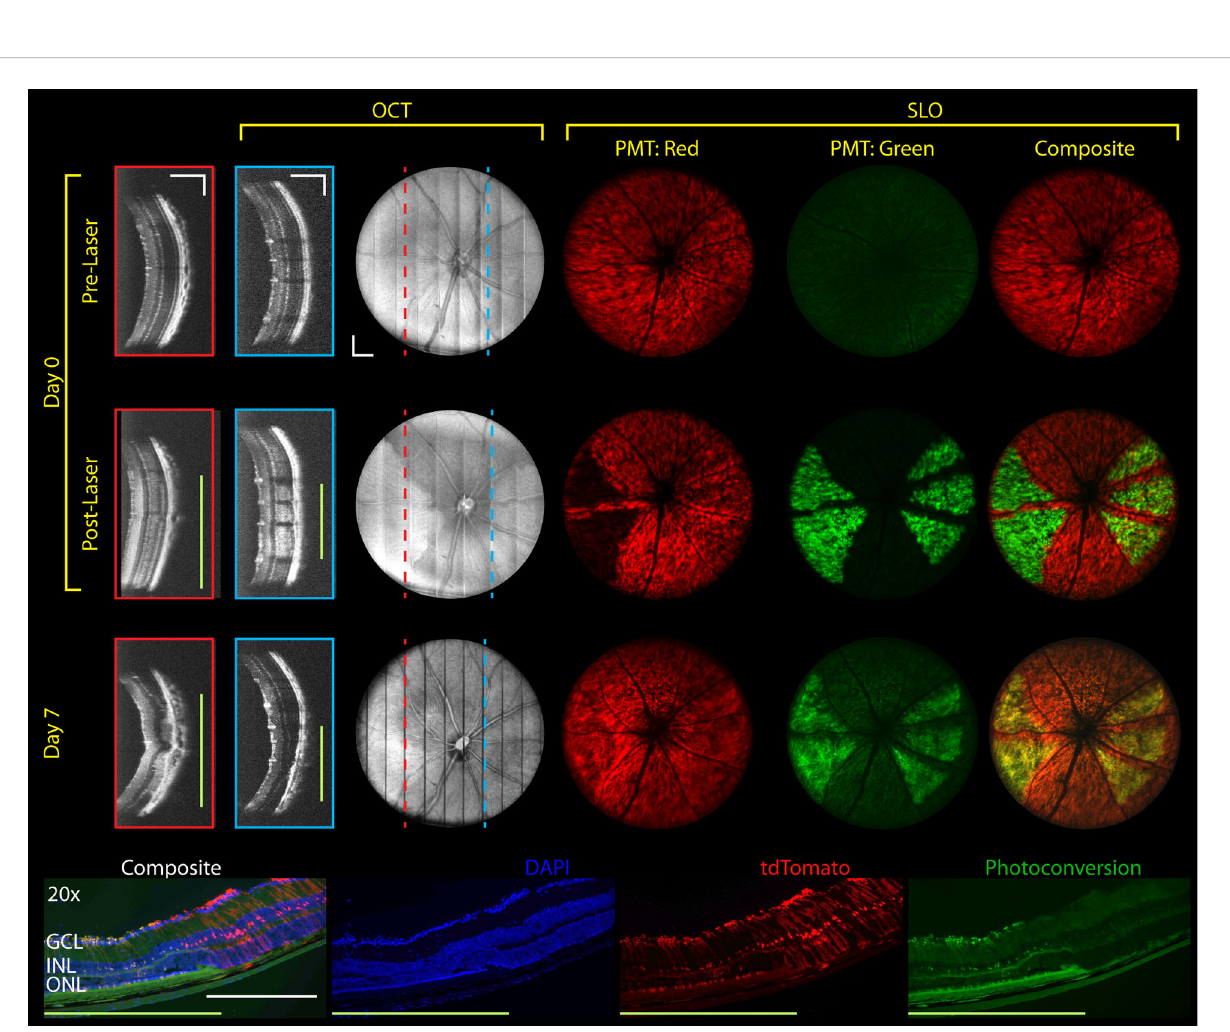
FIGURE 7 Longitudinal MURIN imaging of photodamage patches. Patches were scanned using 50% spot-size overlap 6 mW 200 ms duration laser pulses. Higher and lower injury levels (left and right of the ONH) were created using 4 and 1 laser pulses per location, respectively. OCT images show cross- sections in higher and lower injury locations (red and blue dotted lines and boxes, respectively). On SLO, higher severity patches showed more complete fl uorescence photoconversion and retinal deformation (focal shift on Supplemental Video 3). Photoconversion is con fi rmed on representative histology (bottom) and persists at 7-days post-laser lesioning. Green bars indicate photodamage regions. Scale bar: 250